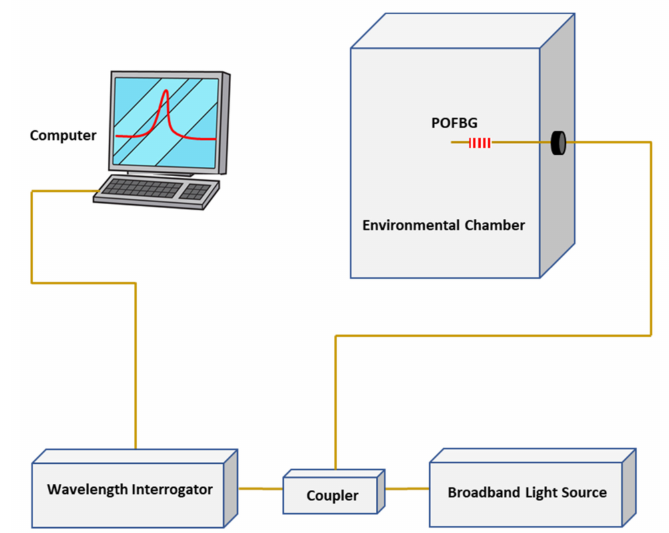
Figure 4. Experimental arrangement of the sensitivity assessment of the polymer sensor.